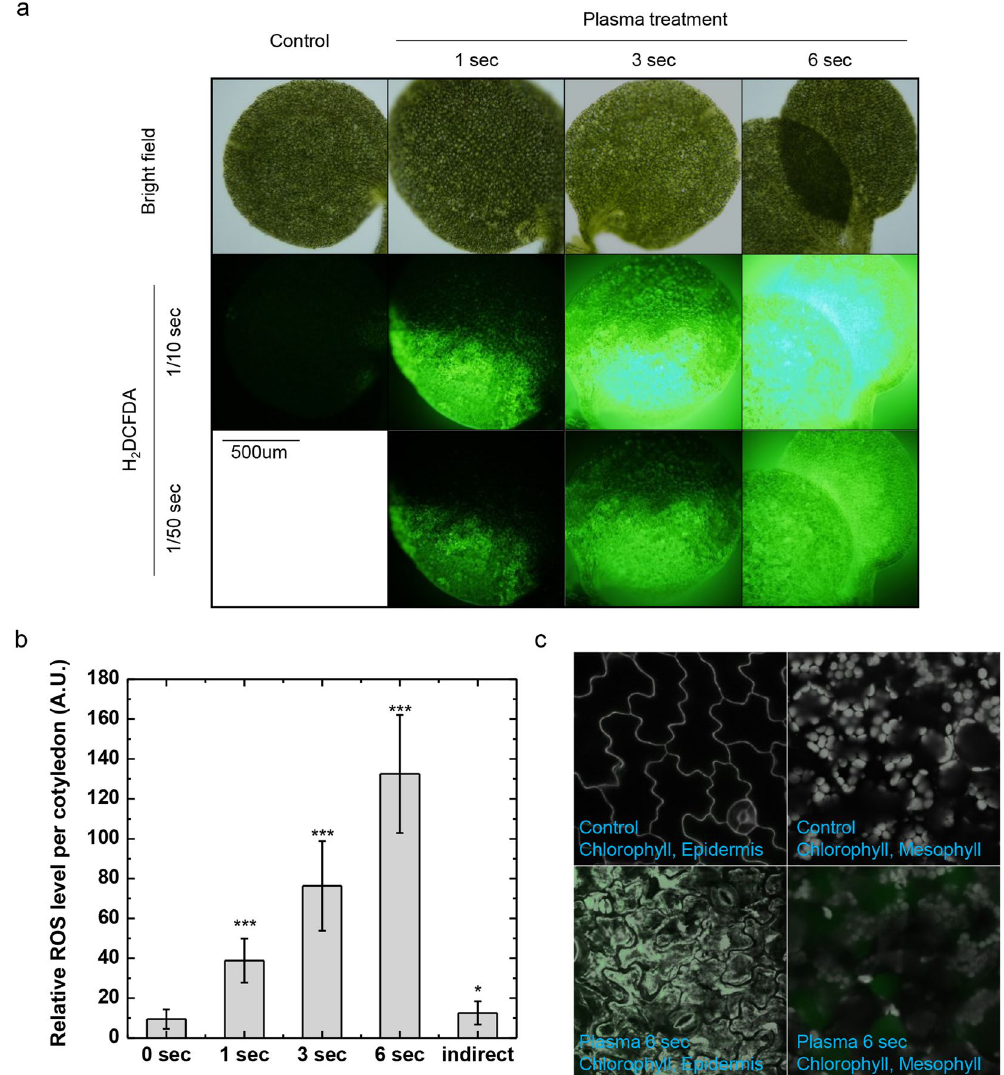
Figure 3. Atmospheric plasma induced ROS accumulation across the treated area in cotyledon. ( a ) DCFDA fluorescence image of cotyledon treated with plasma for indicated times (s). Representative image were determined from 5 experiments for each conditions. ( b ) Relative ROS level was measured in direct plasma treated seedlings and indirectly treated samples. To measure ROS level, we used 20 cotyledons treated with indicated conditions and DCFDA signal intensity were measured with same exposure time taken fluorescence image data. Signal was measured for whole cotyledon as mean grey value. Error bar = SD. Student’s t-test were used to indicate significant difference from Mock treatment, * < 0.05, ** < 0.01, *** < 0.001. ( c ) DCFDA fluorescence image of cotyledon treated with 6 seconds of plasma or not by confocal microscope. Grey signals in epidermis images are propidium iodide fluorescence to visualize cell walls and nucleus, and grey signals in mesophyll images are chlorophyll auto-fluorescence to visualize relative plastid location. Representative image were determined from 5 experiments for each